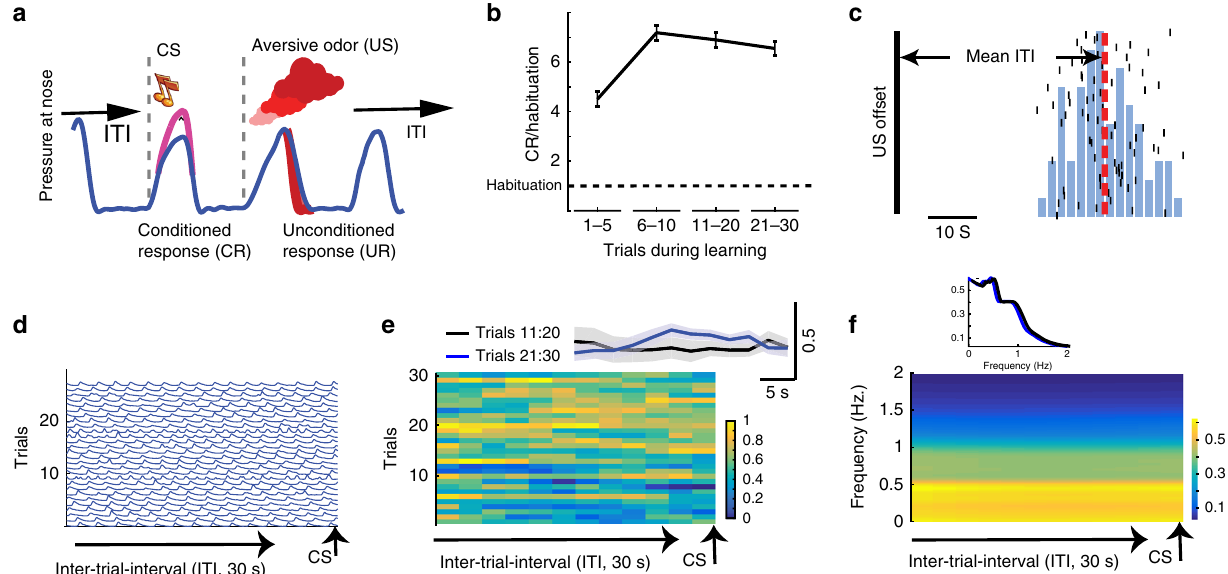
Fig. 1 Conditioning paradigm and behavior during the inter-trial interval (ITI). a A trial scheme: online detection of inhale is used to initiate tone (CS) presentation that is followed by an aversive odor (US) at the onset of the next inhale. Response to the aversive odor is a decreased inhale (UR), whereas the conditioned response (CR) is an increased inhale. b The CR increases during learning. Shown is the CR (inhale size during the 350 ms post CS onset) as proportion of the inhale size during habituation (dashed line). Data presented as mean ± S.E.M. c A histogram of ITI duration from one representative session. Trial occurrences (black vertical line signals US offset) and the initiation of the subsequent trial (black vertical ticks). Dashed red line is the mean ITI at 42 s. d Inhale traces during the ITI aligned to onset of next trial. Shown are data for one session of learning. No clear modulation can be observed toward the end of the ITI. e Inhale modulation during the ITI did not change across learning. Shown is mean ± S.E.M across all learning sessions for the 30 learning trials (one-way ANOVA, p > 0.1, df = 11, f = 0.05). Inset presents mean over trials 11 – 20 and 21 – 30, computed during 30 s of ITI. f No change in inhale frequency across learning trials. Shown is mean power across all learning sessions at each frequency (0.2 – 2 Hz) during the ITI (one-way ANOVA, p < 0.01, df = 11, f = 0.05). Inset presents inhale frequency (mean over days, n days = 82) as power during the whole 30 s of ITI preceding the CS,